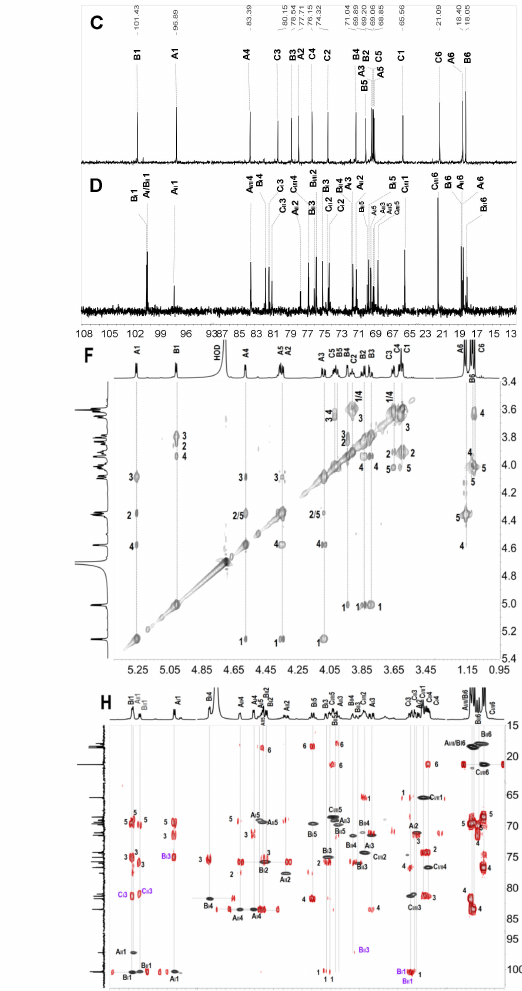
Figure 2. The 1 H ( A , B ) and 13 C ( C , D ) spectra of FI and FII, correlation spectroscopy( 1 H- 1 H COSY) ( E ) and heteronuclear multiple bond correlation ( 1 H- 13 C HMBC) ( F ) of FI; the overlapped spectra ( G ) of 1 H- 1 H COSY (gray), total correlation spectroscopy ( 1 H- 1 H TOCSY)(red) and rotating frame Overhauser effect spectroscopy ( 1 H- 1 H ROESY) (blue) of FII; and the overlapped spectra ( H ) of heteronuclear single quantum coherence ( 1 H- 13 C HSQC) (gray) and 1 H- 13 C HMBC (red).